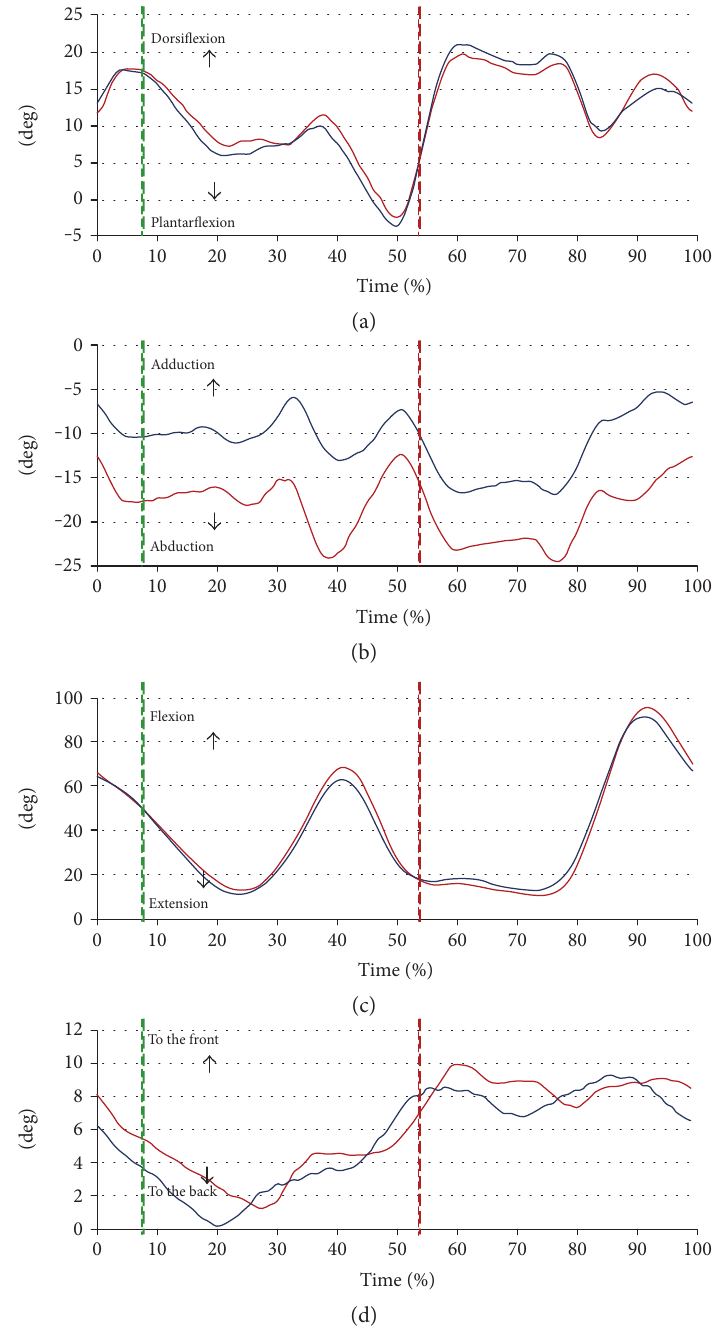
Figure 2: Mean parameters re fl ecting the technique of stepping up of the examined groups in a movement cycle where y- axis represents values of the angle [ ° ]. Blue — instructors, red — nonprofessionals. Vertical green line — vGRF during stepping up, red — during stepping